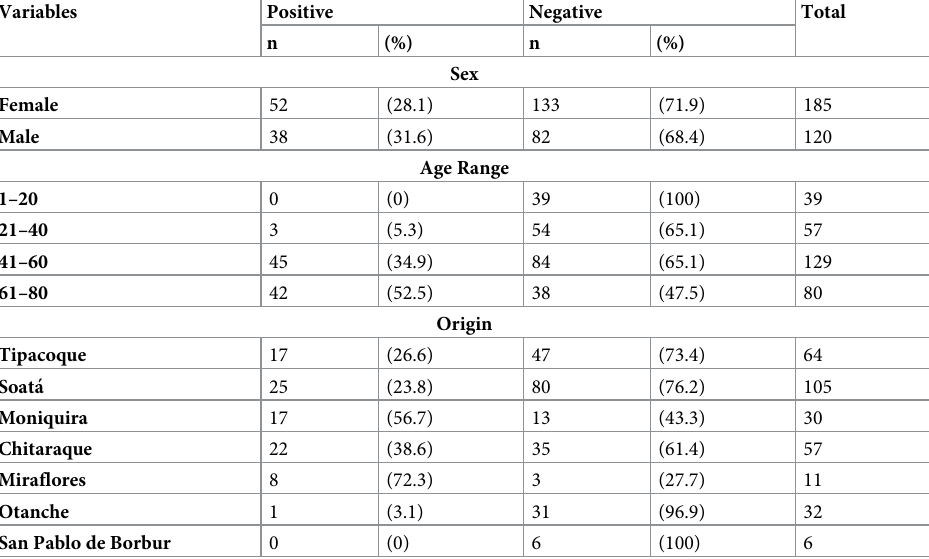
Table 1. Characterization of the population included in the study (n =